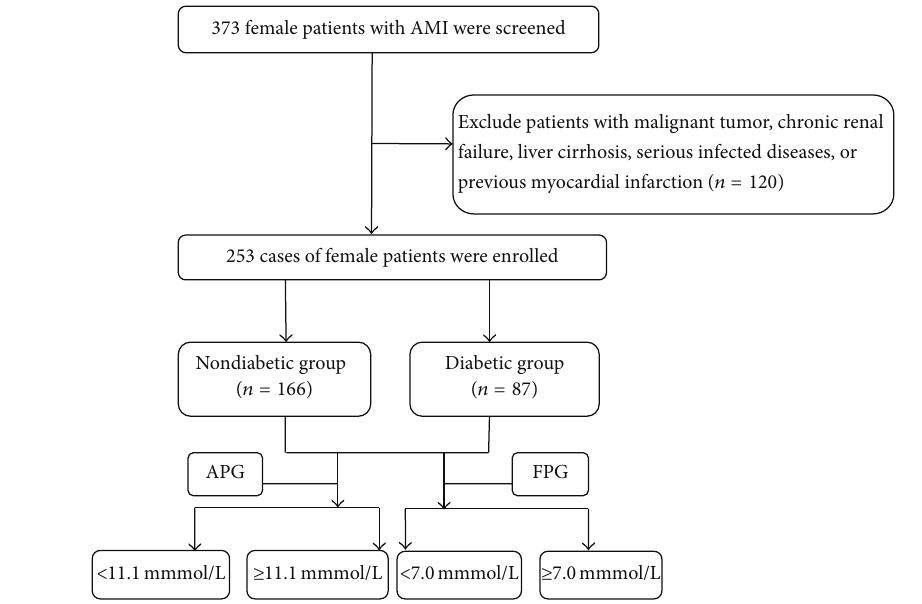
Figure 2: Flow chart of the inclusion of subjects in our study. Table 4: Logistic regression analysis for mortality rate in nondiabetic